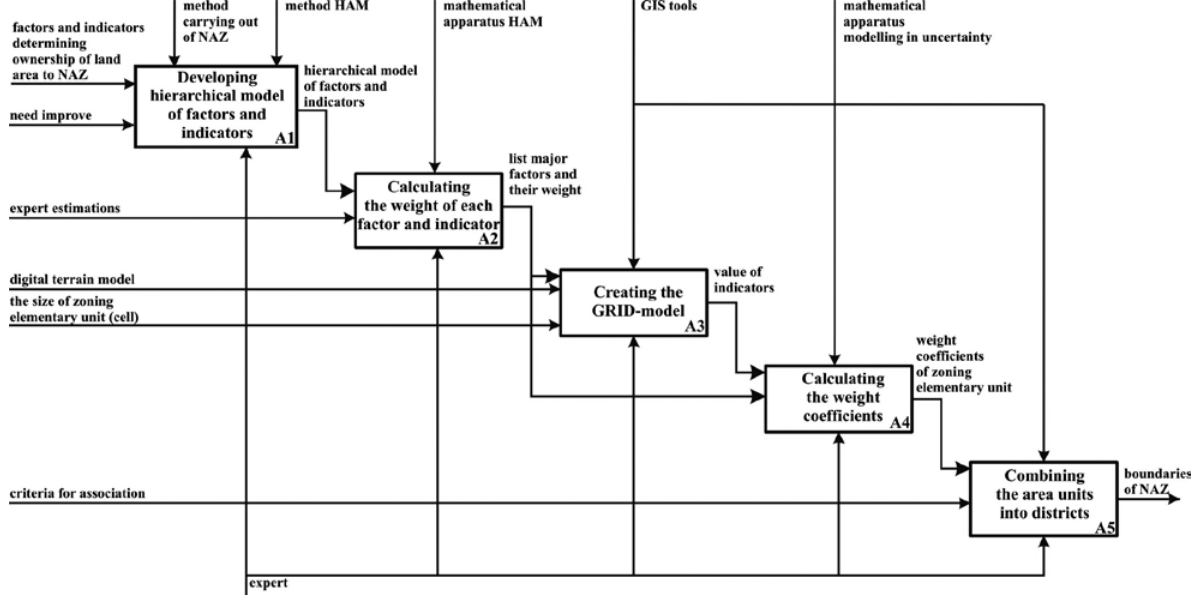
Fig. 1. IDEF0 model of automated natural agricultural zoning